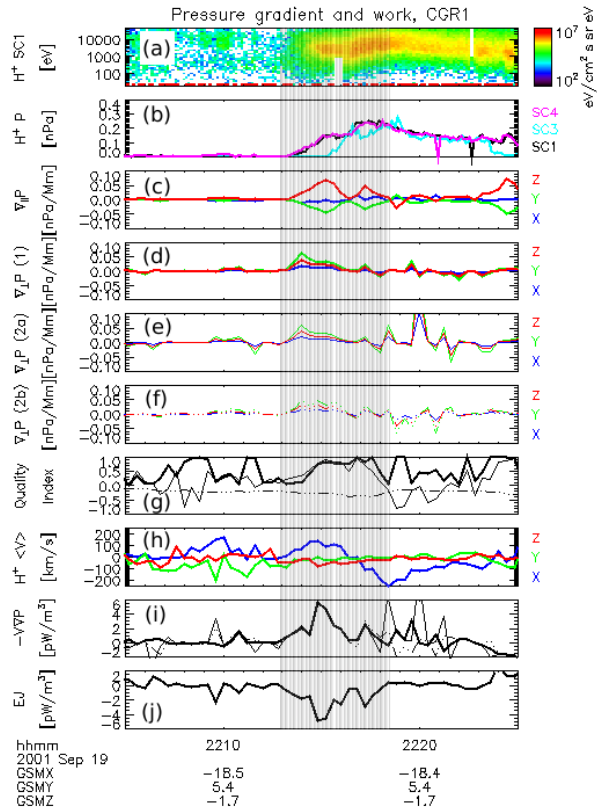
Fig. 6. Pressure gradients and the work of the pressure forces for three different geometric constraints. (a) H + energy spectrogram for SC1. (b) H + pressure for SC1 (black), SC3 (cyan), and SC4 (magenta), averaged over 24s. (c) Pressure gradient parallel to the 3-spacecraft plane (SC1, SC3, SC4), ∇ k p , computed via Eq. 21. (d, e, f) Pressure gradient normal to the 3-spacecraft plane, ∇ ⊥ p , computed via Eq. (32) (d) and Eq. (34) (e, f), with the geomet- ric constraints ∇ p k J × B , ∇ p ⊥ J , and ∇ p ⊥ B , respectively. (g) Quality indices | ˆ e × ˆ n | 2 (for panel d) and ˆ e · ˆ n (for panels e and f), with thick, thin, and dashed-dotted line, respectively. (h) H + velocity, averaged over spacecraft and over 24 s. (i) The work of the pressure forces, W K = − v ·∇ p , with ∇ p = ∇ k p +∇ ⊥ p , corre- sponding to the three estimates of ∇ ⊥ p . Same linestyles as for the quality indices. Note the peak at 22:15 and the spikes associated with low quality indices. (j) The power density, E · J , indicating the energy conversion rate. The energy conversion reaches a neg- ative peak at 22:15, simultaneous with the peak in W K , consistent with a generator process.